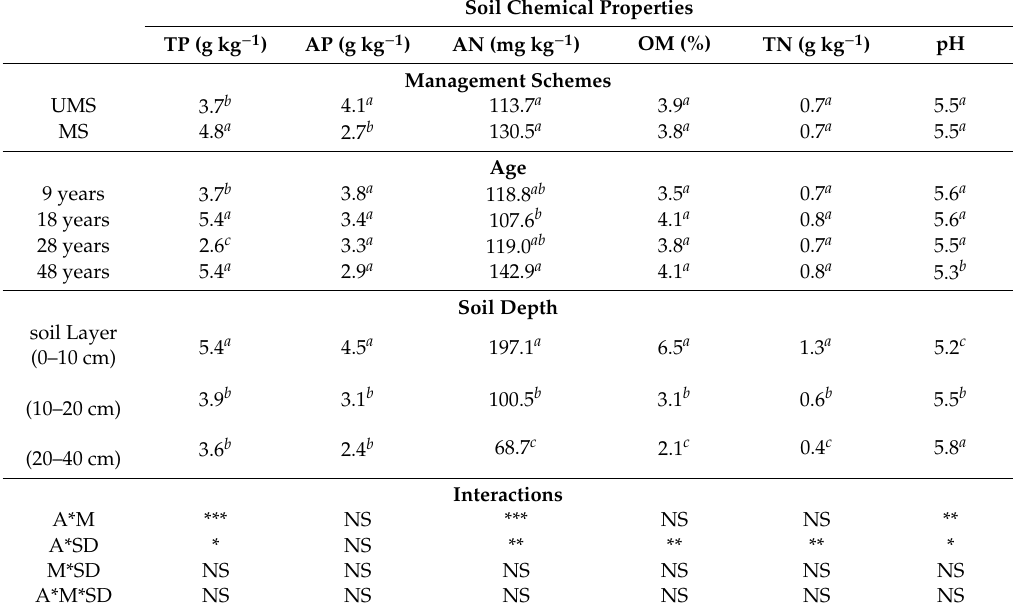
Table 5. Soil chemical properties in di ff erent age groups and management treatments in Masson pine ( P. massoniana ) plantations. Di ff erent lower-case letters within columns indicate the significance level among di ff erent